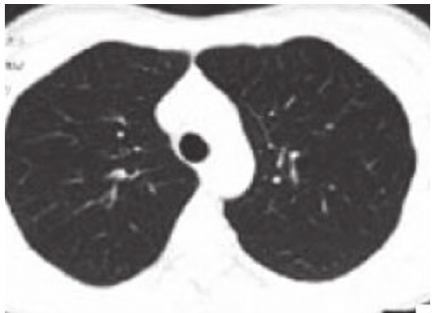
Figure 3: A normal HRCT chest obtained 2 months after discharge.